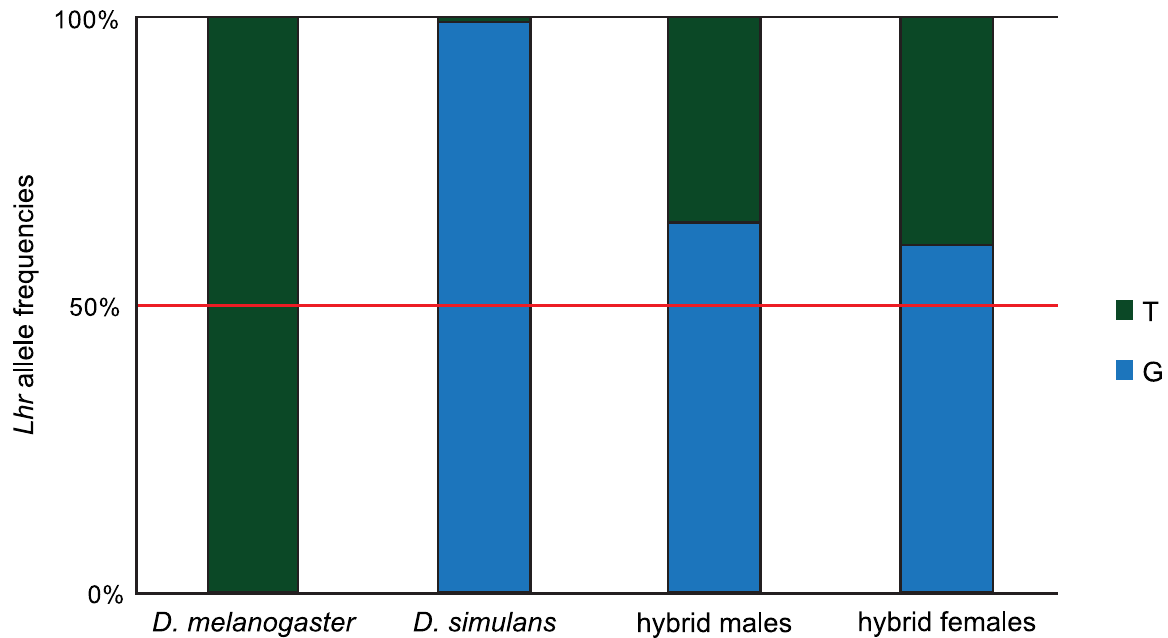
Figure 6. Asymmetric expression of Lhr orthologs in hybrids. Pyrosequencing across a SNP fixed between Lhr orthologs was used to measure the ratio of allelic transcription in pure-species and hybrid larvae that were 3–5 days old. Lhr transcript from pure species D. melanogaster is 100% for the D. melanogaster -specific variant of the SNP. For D. simulans 2 out of 3 of the technical replicates from one of the cDNA preparations showed 100% of transcripts with the D. simulans -specific variant of the SNP; a small amount of the D. melanogaster -specific SNP detected in the 3rd replicate most likely reflects error or contamination. The D. simulans -specific SNP is detected at levels significantly greater than the expected 50% in both male and female hybrids ( p , .0001 and p =.005 for hybrid males and females, respectively, by two-tailed t